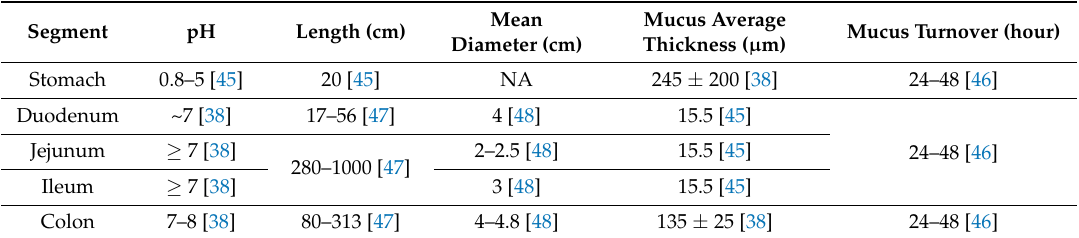
Table 1. Characteristics of different segments of the human gastrointestinal (GI)